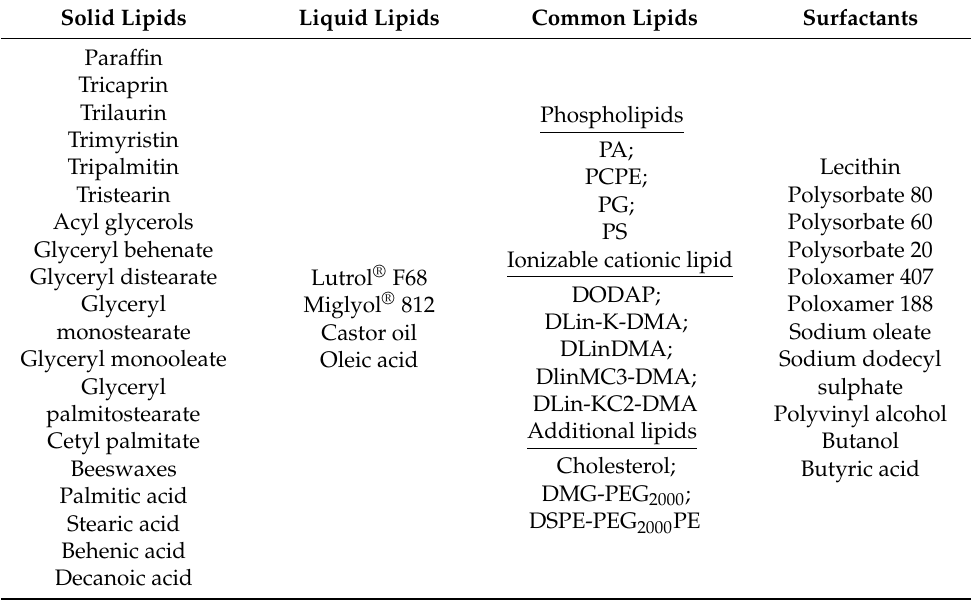
Table 1. List of lipids and surfactants used for the synthesis of LNPs [1,52–55]. Solid